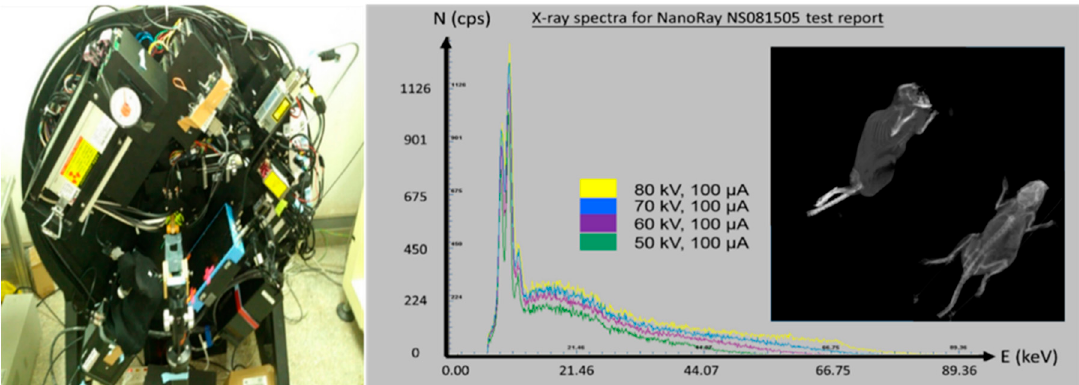
Figure 1. The prototype of the laboratory designed micro-computed tomography (CT) system and its 50–80 kVp X-ray spectrum.